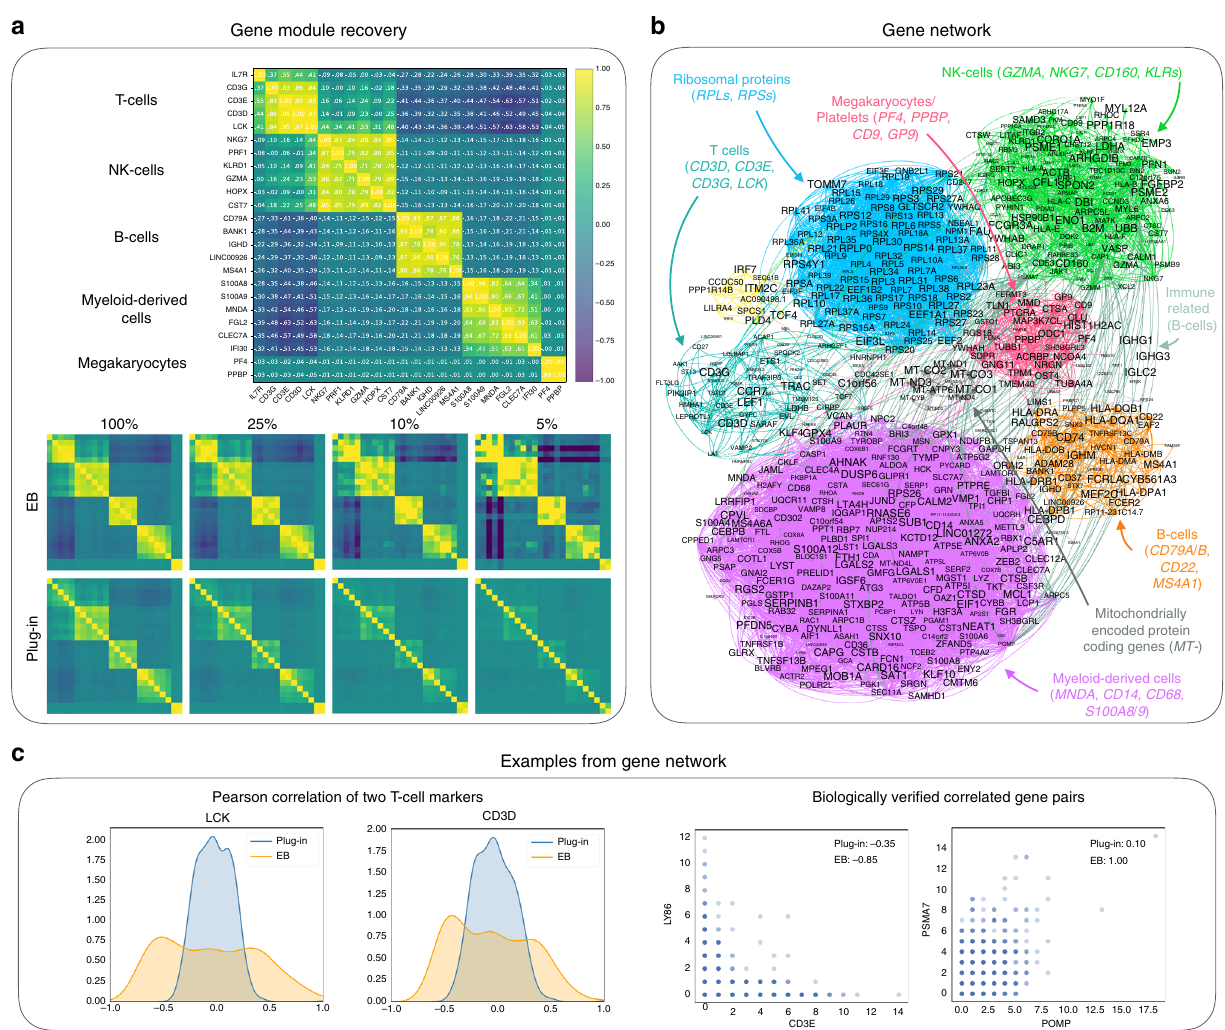
Fig. 4 Gene module and gene network analysis. a Top: the EB-estimated Pearson correlation for some marker genes in pbmc_4k are visualized, ordered by different cell populations (top). The clear block-diagonal structure implies that the EB estimator is capable of capturing the gene functional groups. As a comparison, the plug-in estimator also recovers those modules but with a weaker contrast (bottom left panel, plug-in with 100%). Bottom: a subsample experiment further shows that the EB estimator can recover the module with 5% of the data. For the plug-in estimator, the fi rst block (T cells) is blurred with 25% of the data, and the entire structure vanishes with 10% of the data. b Gene network based on the EB-estimated Pearson correlation using the pbmc_4k dataset. Most gene modules correspond to important cell types or functions, including T cells, B cells, NK-cells, myeloid-derived cells, megakaryocytes/platelets, ribosomal protein genes, and mitochondrially encoded protein-coding genes. c Left: the estimated Pearson correlations between all genes and LCK (1st panel) and CD3D (2nd panel), two known T-cell markers. There are three modes for the EB-estimated values, where the positive mode, the zero mode, and the negative mode correspond to genes in the same module, different modules, and irrelevant genes, respectively. The plug-in estimated values are nonetheless much closer to zero even for the truly correlated ones, indicating an arti fi cial shrinkage of the estimated values. Right: two instances where the EB estimates are signi fi cantly different from the plug-in estimates. The axes represent read counts, and the color codes the number of cells. Both gene pairs are biologically validated (see Gene network analysis in Methods). See also Supplementary Figs. 11 – 12 for more